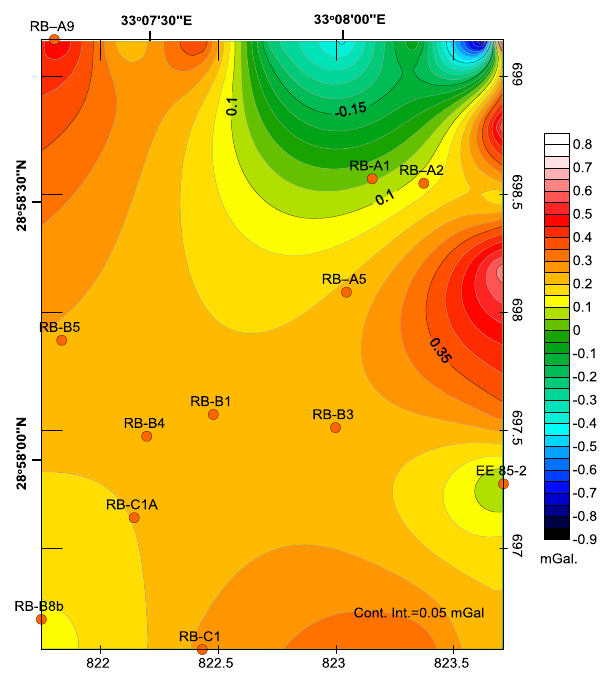
Fig. 5 Second vertical derivative map of the Bouguer gravity